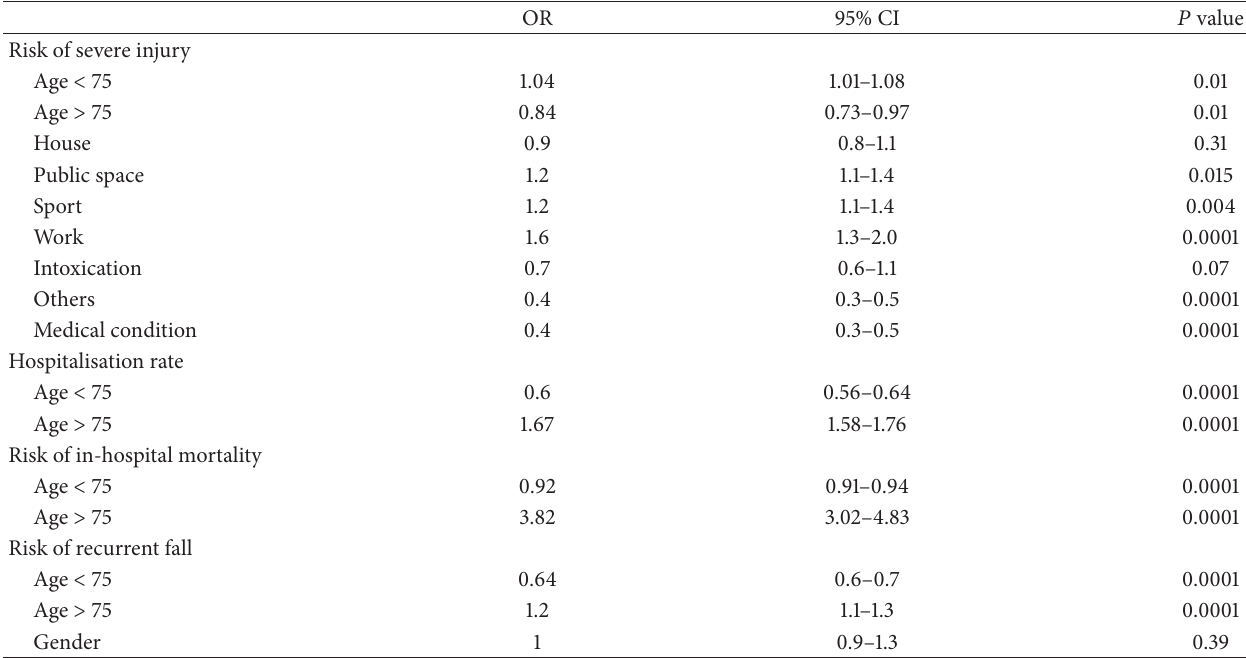
Table 2: Risk analysis.